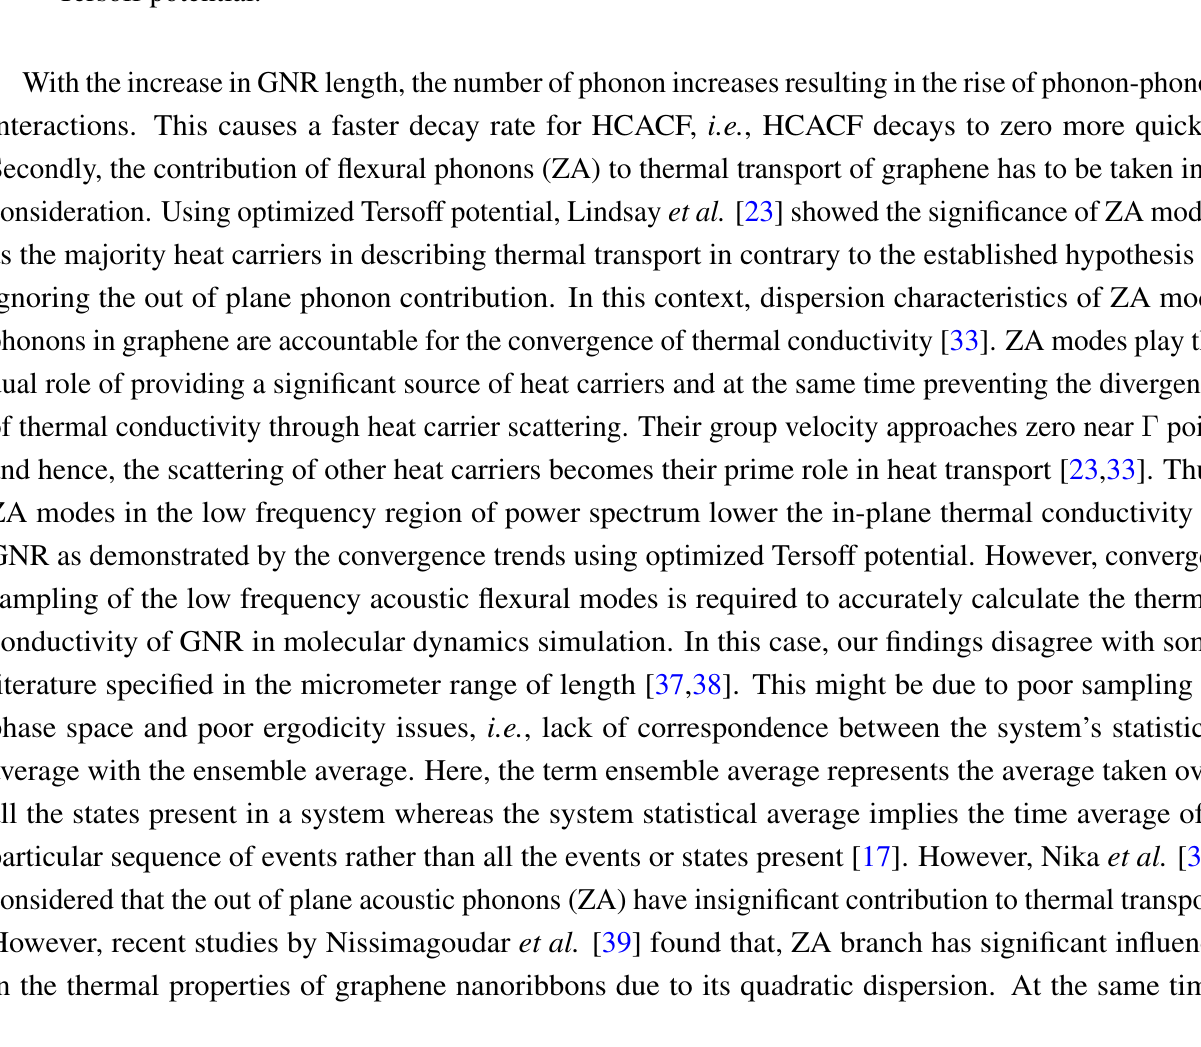
Figure 8. Envelopes of decaying heat current autocorrelation function (HCACF) profiles as a function of correlation length for varying lengths of GNRs (1nm width) using optimized Tersoff